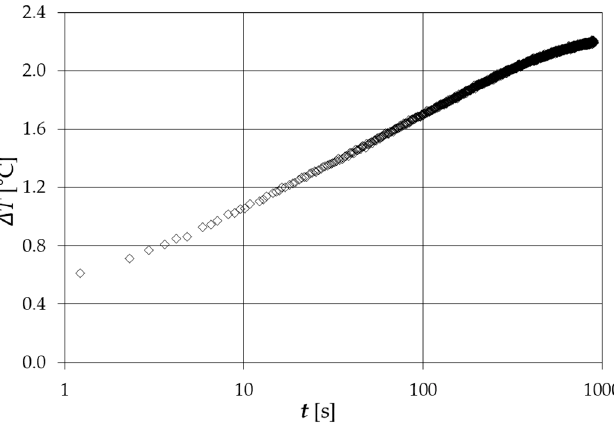
Figure 4. Typical temperature trend versus time of a thermal conductivity measurement. The uncertainty analysis was evaluated according to the (ISO/IEC 1995), i.e., two types of uncertainty were evaluated, type A and